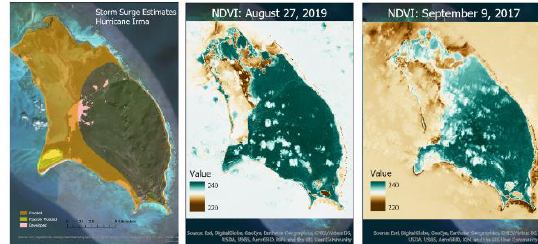
Figure 1: A (left): Hurricane Irma storm surge model. Areas in orange are within the storm surge area. The area in yellow, Palmetto Point, was likely flooded during the event. A value of 2.64 m was initially used as the height of terrain impacted by the storm surge and refined by ground observations and local